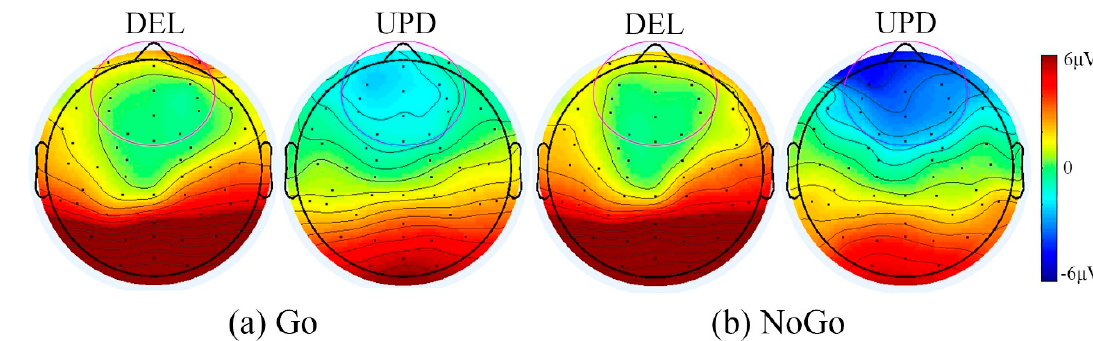
Figure 5. Heat maps between DEL and UPD groups on baseline Go/NoGo task. Here, a symmetrical color bar is used. The red indicates activity with positive amplitude, the blue indicates negative amplitude, and the green indicates activity with zero value. Range = +/ − 6 microvolts. The channels used in ERP analysis are highlighted (t = 245ms). ( a ) Go condition when viewing non-food images. ( b ) NoGo condition when viewing food images.